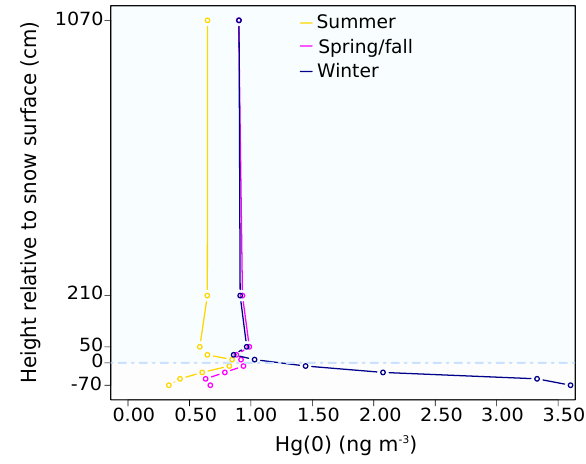
Figure 11. Mean Hg(0) concentration (ngm − 3 ) measured at vari- ous heights above and below the snow surface (cm) at Concordia Station in summer (yellow), spring/fall (purple), and winter (dark blue) The horizontal light blue dashed line represents the snow sur-